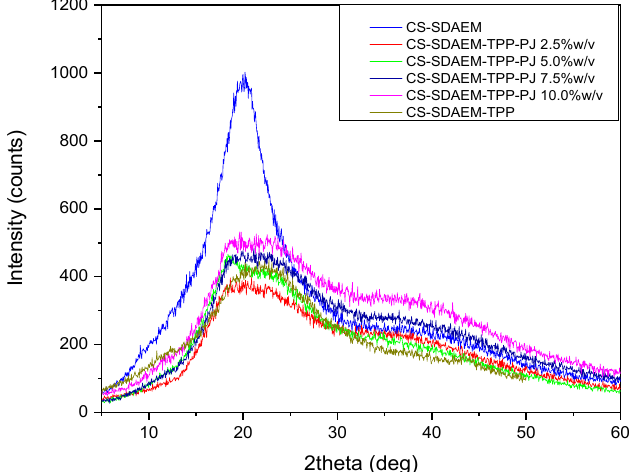
Figure 8. XRD patterns of CS, CS empty nanoparticles and CS nanoparticles 2.5, 5.0, 7.5 and 10.0 wt% containing PJ.